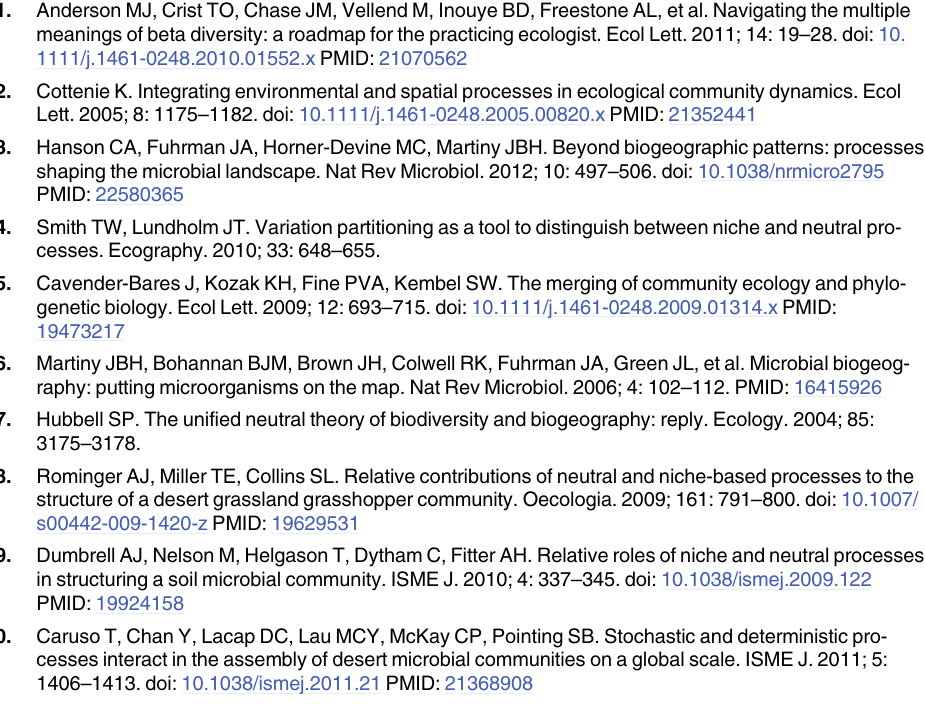
position. Numbers in parenthesis represent the number of phylotypes and orders assigned to each division respectively. (TIF) S2 Fig. The relationships of taxonomic dissimilarity (a and b) and betaMNTD (c and d) versus vertical distance and environmental heterogeneity (environmental distance), respec- tively. Solid lines represent linear regressions and the significance levels are determined by Mantel test (9999 permutations).